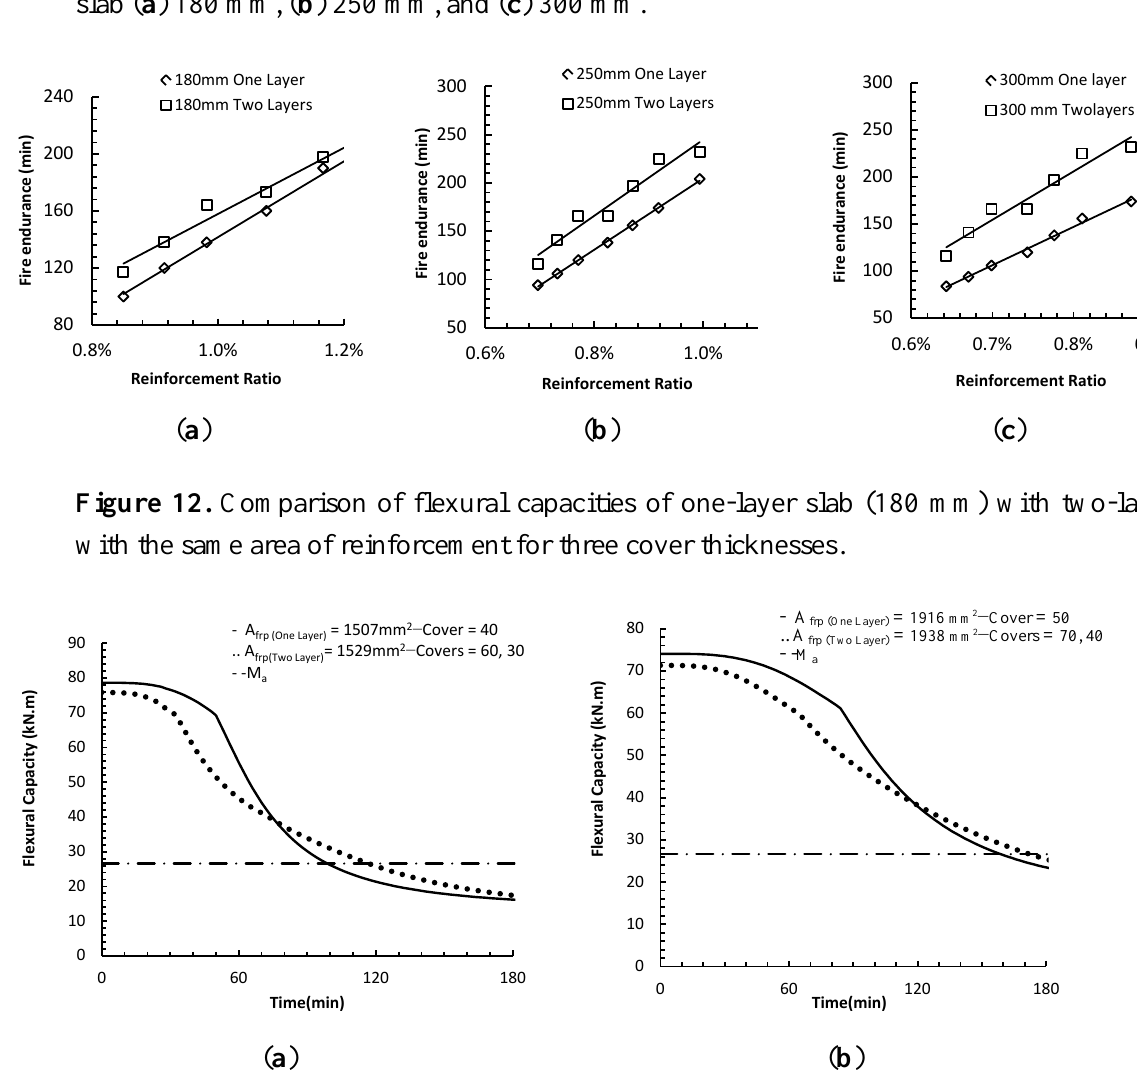
Figure 11. Fire endurance of one-layer compared to two-layer FRP reinforced concrete